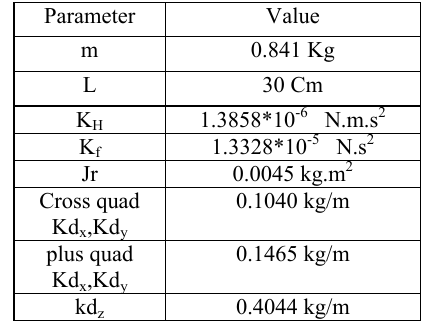
Table 2. Mass moment of inertia